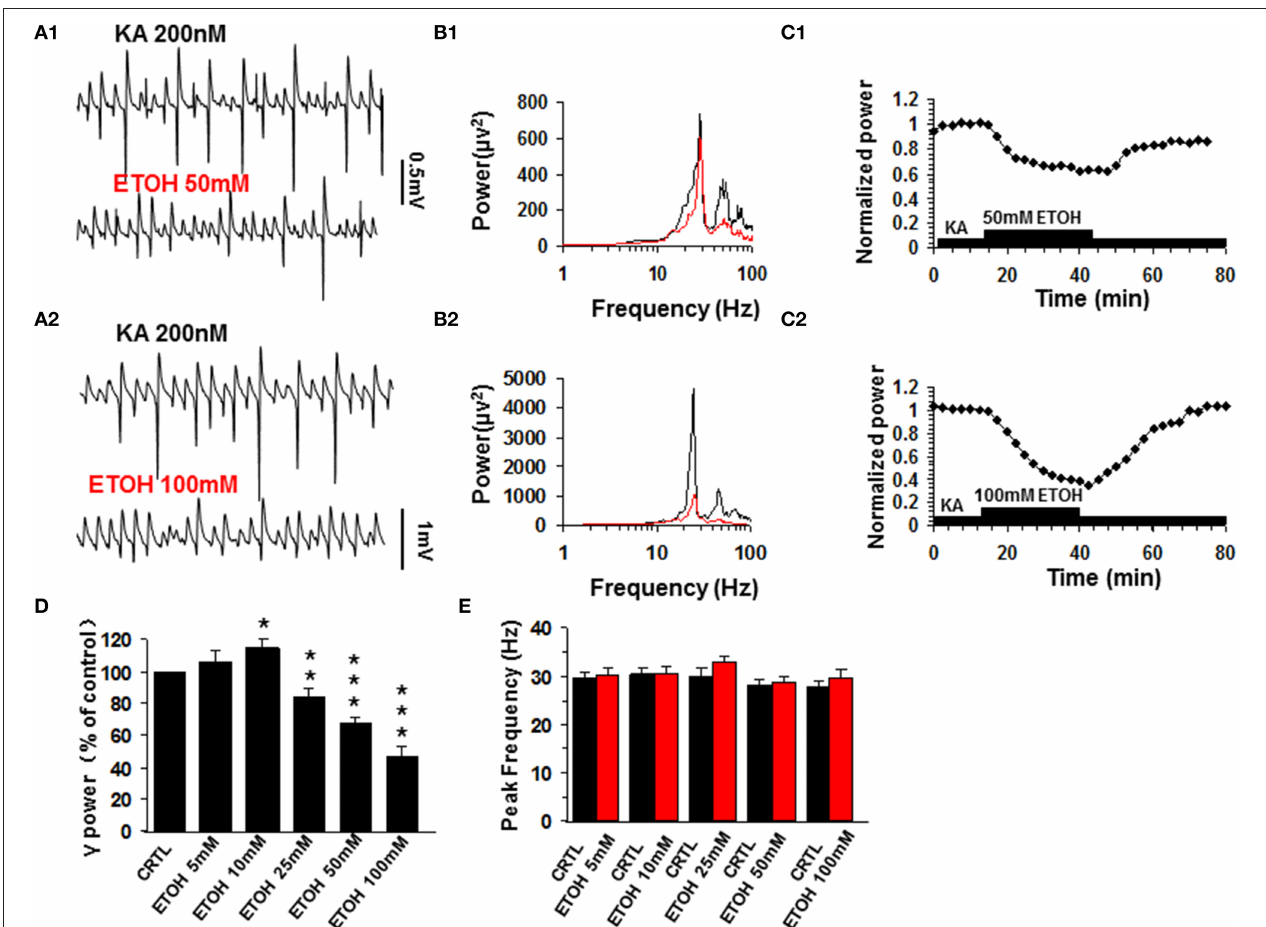
FIGURE 1 | The effect of ethanol (ETOH) on kainate-induced γ oscillations. (A) Field potential recordings from the CA3 stratum pyramidale, before and after application of 50mM ethanol (A1) or 100mM ethanol (A2) . (B) Power spectra corresponding to (A1,A2) . (C) The time courses of γ power (normalized to the average γ power in the last 5min before ethanol application (baseline) shows a reversible reduction of γ power. (D) γ power as % of baseline γ power for different concentrations of ethanol. (* P < 0.05; ** P < 0.01; *** P < 0.001, compared with baseline, paired t -test, n = 12, 11, 8, 8, and 10 for 5, 10, 30, 50, and 100mM ETOH, respectively). (E) Peak frequency of γ oscillations in control and for the different concentrations of ethanol ( n = 8).